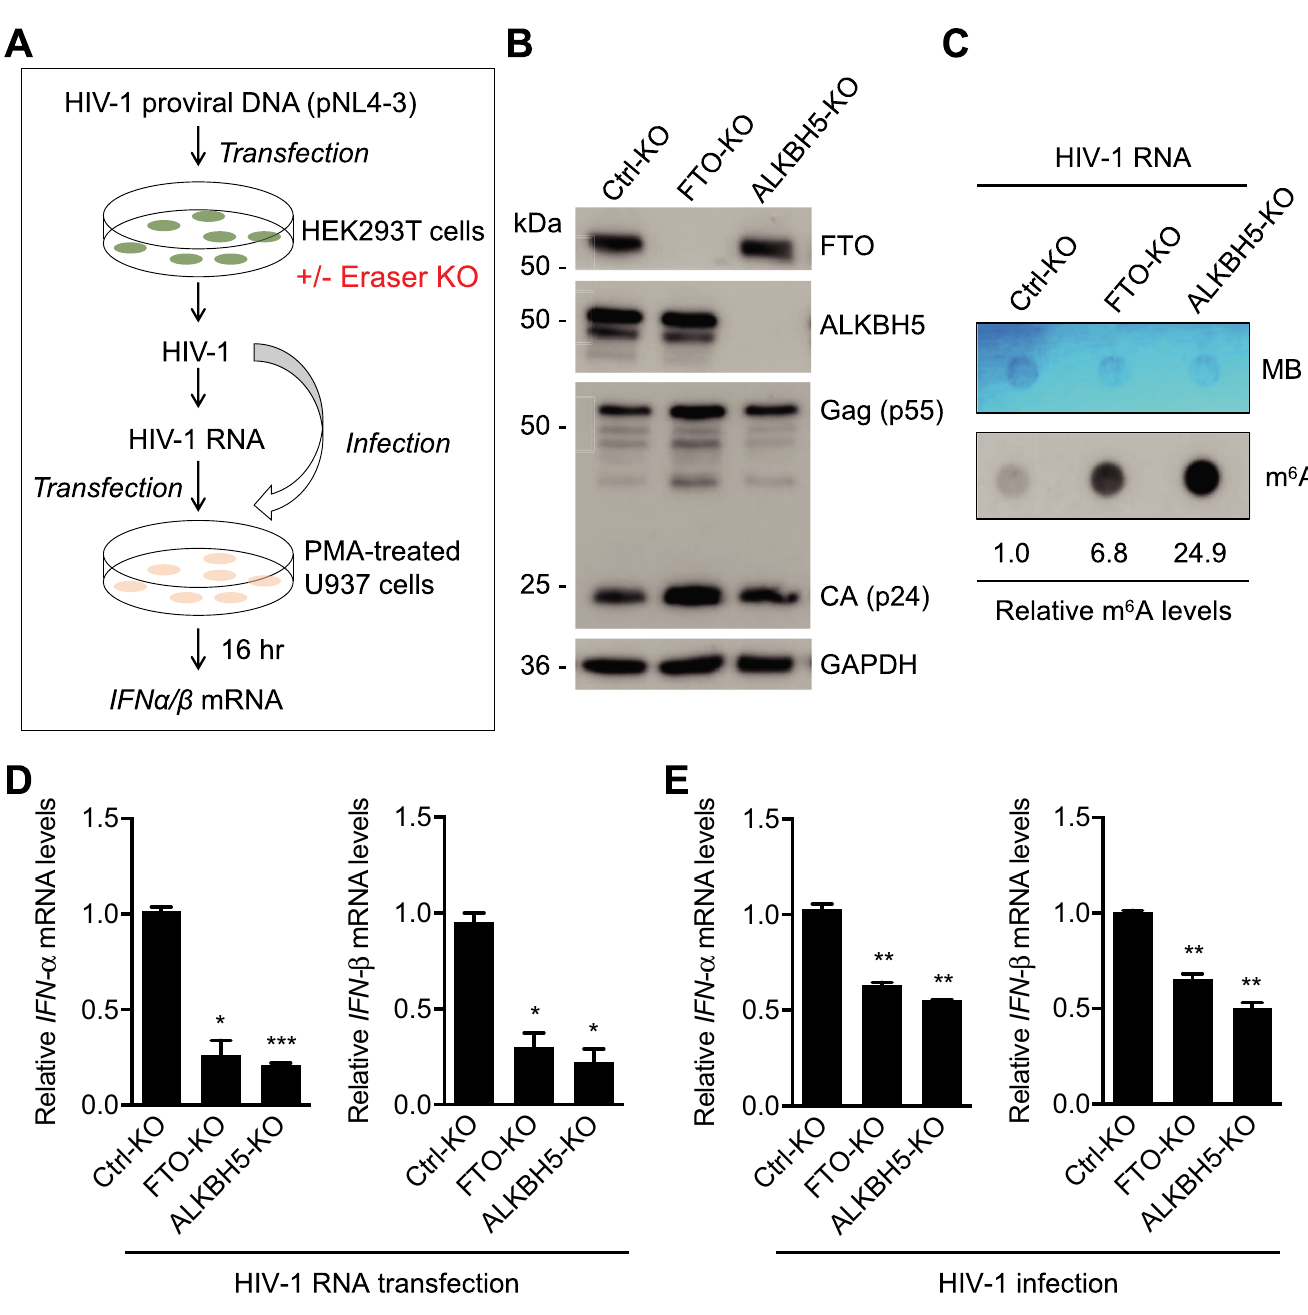
Fig 7. Knockout of erasers increases m 6 A levels in HIV-1 RNA and reduces IFN-I induction. (A) A schematic diagram of the experimental approach. (B) A single clone-derived control, FTO or ALKBH5 knockout (KO) HEK293T cells were transfected with the HIV-1 proviral DNA pNL4-3. After 48 hr, cells were collected for Western blotting analysis. (C) HIV-1 from the KO cells were collected and viral genomic RNA m 6 A level was determined by the dot-blot assay using 200 ng viral RNA. Methylene blue (MB) staining was used as an RNA loading control. (D) HIV-1 RNA (250 ng) from KO cells were transfected into PMA-differentiated U937 cells. After 16 hr, cells were collected for the analysis of IFN- α and IFN- β mRNA levels by RT-qPCR. The results are shown as means ± S.D. of three repeats with similar result. � P < 0.05, ��� P < 0.0005. Un-paired t-test was used for statistical analysis. (E) HIV-1 (250 pg of p24) from KO cells were used to infect PMA-differentiated U937 cells for 16 hr, and cells were collected for the analysis of IFN- α and IFN- β mRNA levels by RT-qPCR. The results are shown as means ± S.D. of three repeats with similar result. �� P < 0.005. Un-paired t-test was used for statistical